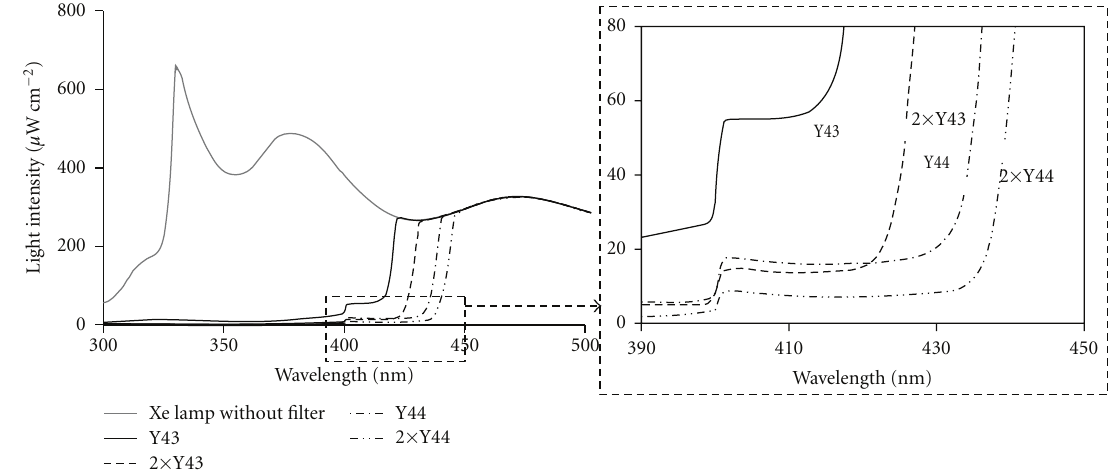
Figure 3: Light emission spectra of xenon lamp with one or two cut-o ff filters: Y43, Y44.